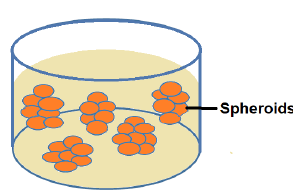
Figure 6. Schematic representation of a scaffold free 3D cell culture in the form of